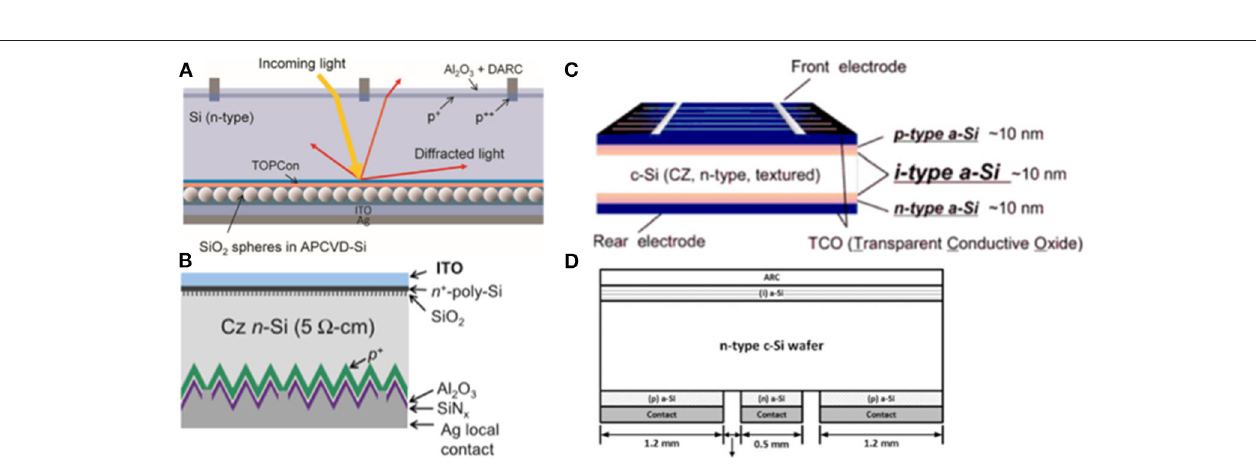
FIGURE 12 | (A) TOPCon with rear side sphere gratings (reproduced from ref. 81, copyright 2018, Elsevier). (B) The cell structure with boron-diffused emitter on the textured side and tunnel oxide passivating nþ poly-Si contact on the other side (reproduced from ref. 14, copyright 2020, Elsevier). (C) Structure of an HITsolar cell. (D) Schematic of the HIT-IBC structure (reproduced from ref. 17, copyright 2015, Wiley VCH).